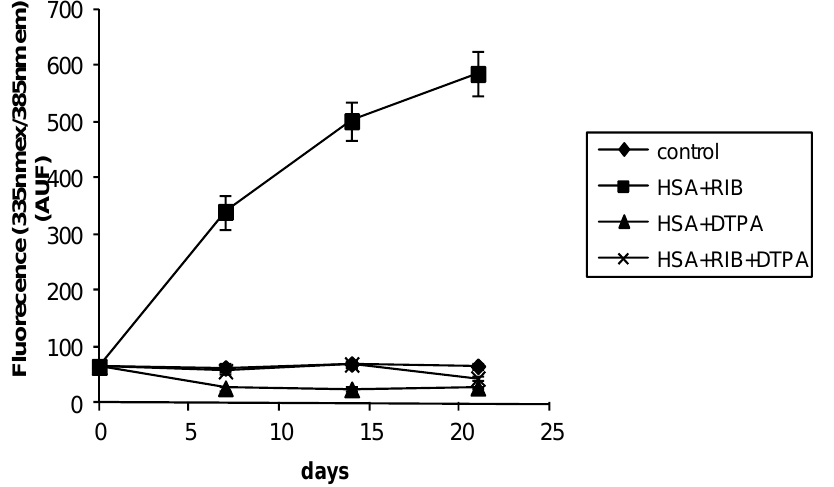
Figure 6. Effects of ribose, DTPA, and ribose + DTPA on 335/385nm fluorescence of HSA during 21 days of